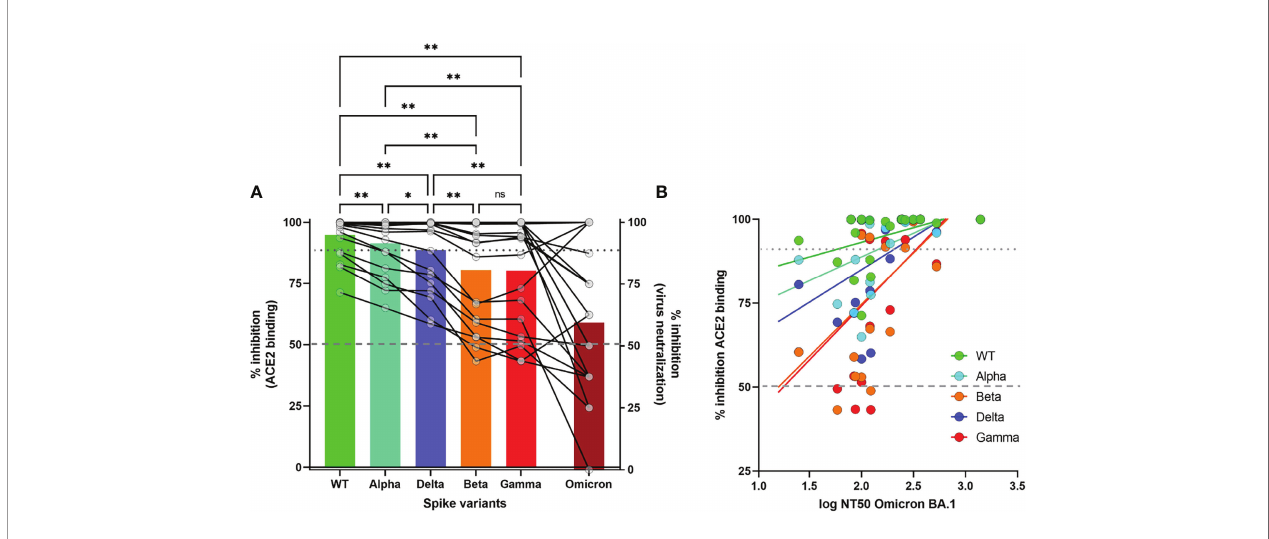
FIGURE 5 | Correlation of surrogate neutralizing antibody levels (%inhibition) against WT and 4 VOC with virus-neutralization assay for Omicron BA.Pseudoneutralization is expressed as % inhibition of recombinant ACE2 binding for 4 VOC. Virus neutralization of Omicron is expressed as % inhibition at 1/100 dilution ( Figure 5(A) ) or 50% Neutralizing Titer (NT50) of cytopathogenic effect ( Figure 5(B) ). Statistical analysis by One-way ANOVA with stringent FDR correction for multiple comparisons (**p<0.01, *p<0.05, ns, not signi fi cant). Correlation between both assays was measured by Spearman ’ s Rho coef fi cient (p<0.05 for all 5 Spike variants). Dashed and dotted grey lines depict 50% and 90% inhibition,